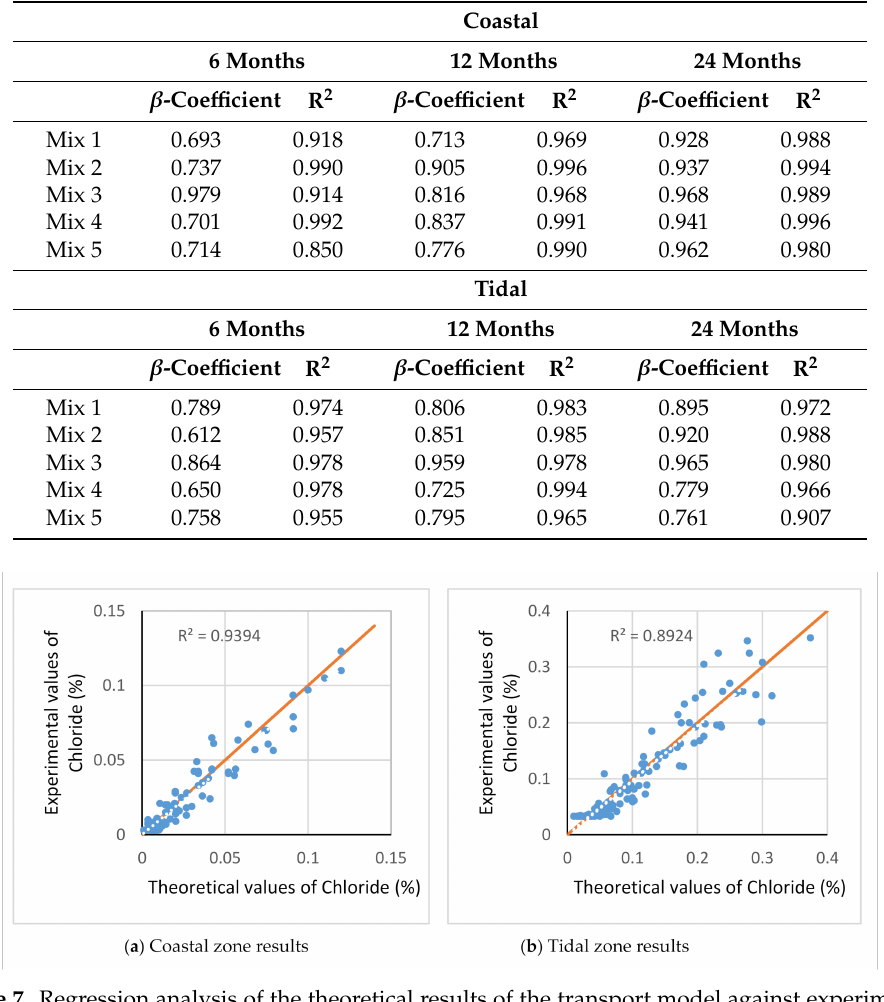
Figure 7. Regression analysis of the theoretical results of the transport model against experimental results. ( a ) Results from blocks located in coastal zone, ( b ) Results from blocks located in tidal